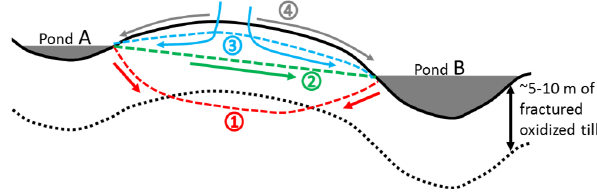
Fig. 10. Conceptual water flow paths (arrows) between two adjacent ponds in the prairie pothole region. Red line and arrows (1) indicate groundwater levels and flow paths, respectively, for dry conditions. Green line and arrows (2) indicate wet conditions where pond A is feeding pond B via the subsurface effective transmission zone. Blue lines and arrows (3) show wetter conditions with a mounded water table and flow diverging from a groundwater divide between the ponds. Gray arrows (4) show typical flow paths for snowmelt water over frozen soils, away from the topographic